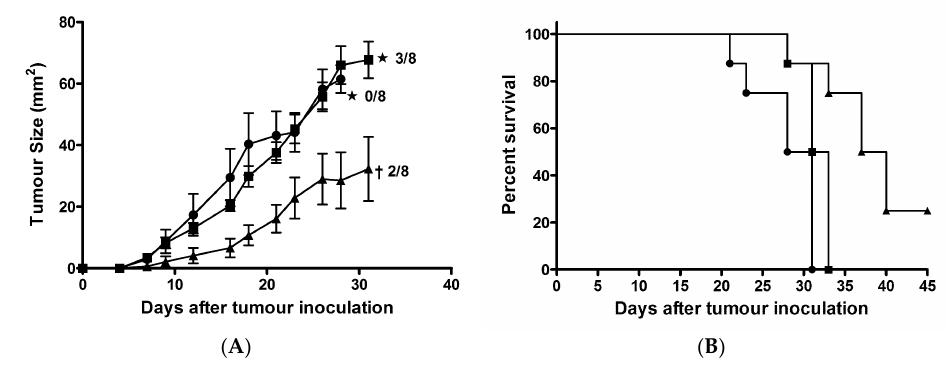
Figure 8. Tumour growth is delayed by immunization ( A ). C57BL/6 mice were immunised on days 0, 10 and 17 with PBS (●), 100 µg AntpMAPMUC1tet ( ■ ) or 100 µg AntpMAPMUC1tet + 50 µg CpG ( ▲ ) then inoculated subcutaneously 7 days after final immunisation with 2 × 10 5 B16-MUC1 melanoma cells into the abdomen. Tumour growth was recorded. Data showing the product of individual perpendicular measurements (mm 2 ) and days post tumour inoculation. Number of tumour-free mice (†) and number of surviving mice ( ★ ) is also shown. Kaplan–Meier survival curves for each immunised group are shown ( B ).